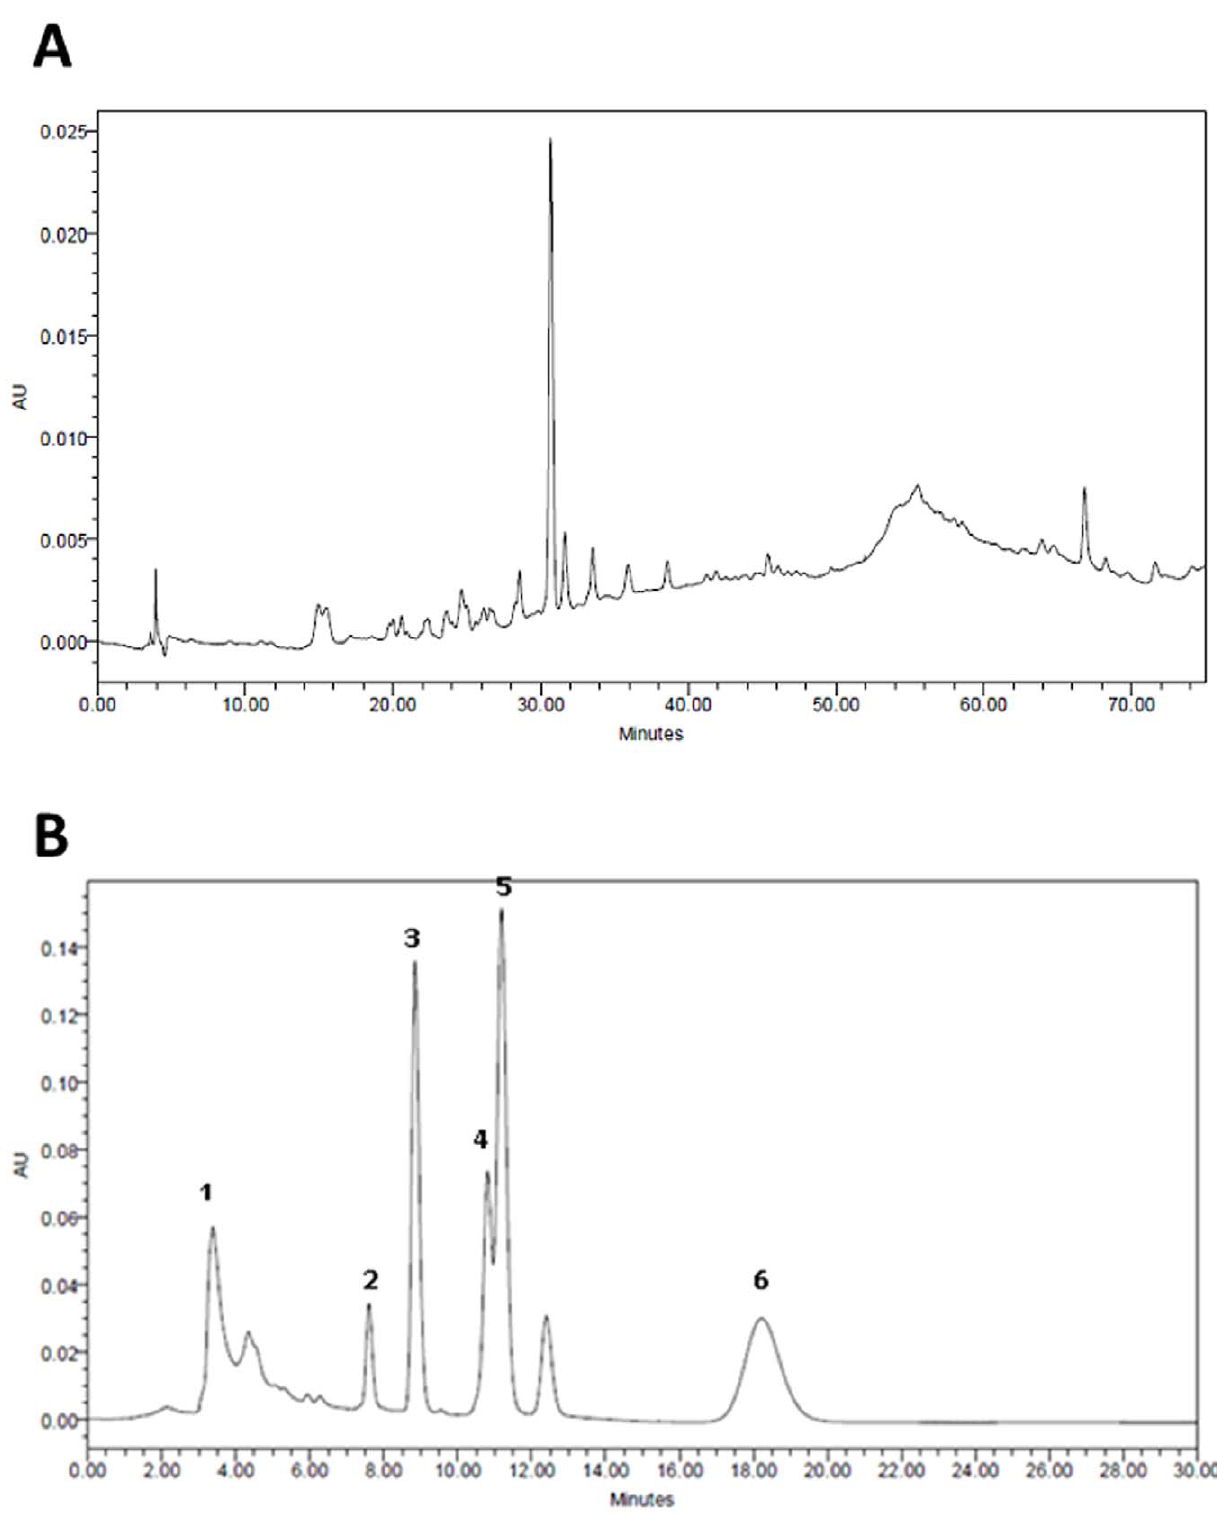
Figure 1. HPLC results. (A) Chromatogram of the BuOH fraction of U. tomentosa showing phenolic compounds, including proanthocyanidins in the region between 50 and 60 minutes. (B) Chromatogram of the CHCl 3 fraction of U. tomentosa . The following compounds were tentatively identified as 1- speciophylline; 2- uncarine F; 3- mitraphyline; 4- isomitraphyline; 5- pteropodine and 6- isopteropodine by comparison with data from the literature.